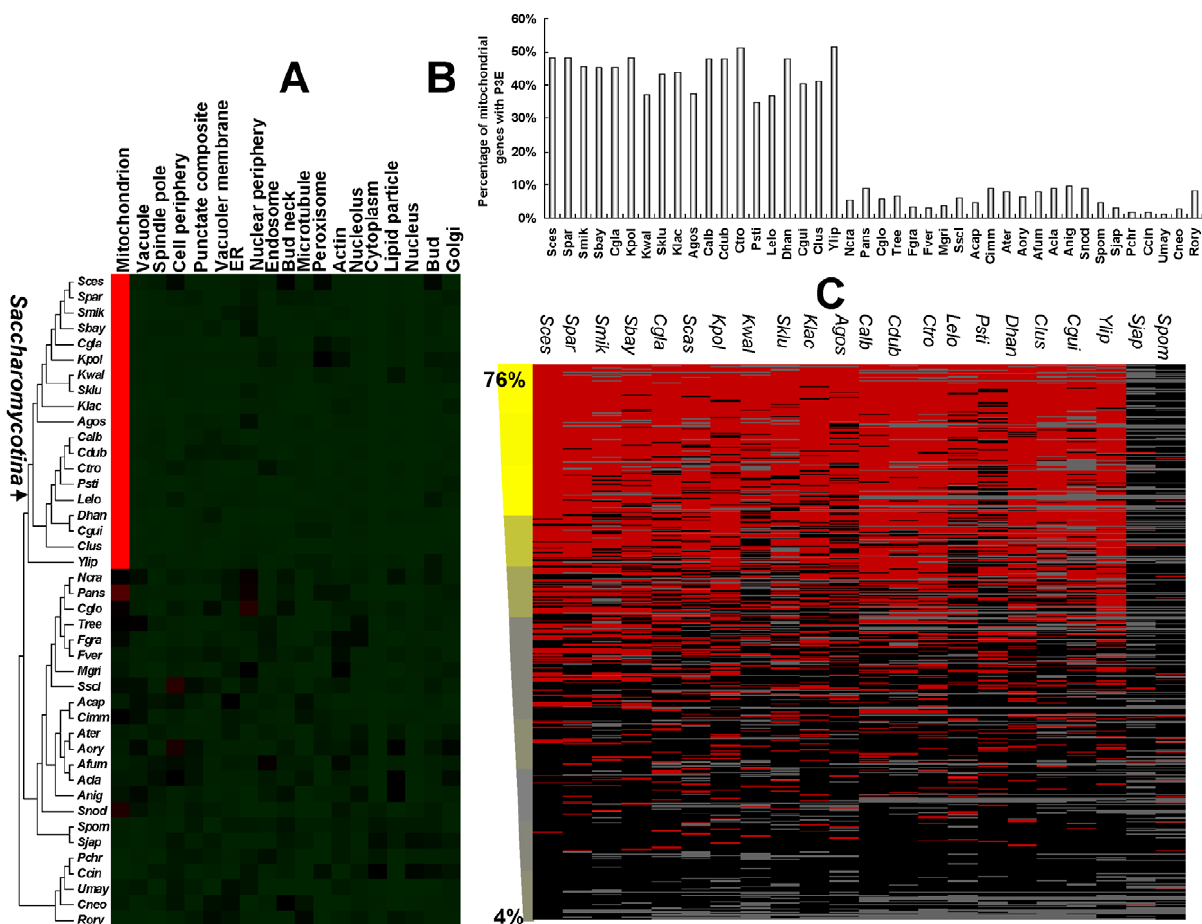
Figure 2. The evolution of the puf3p regulon and mitochondrial biogenesis. (A) Enrichment of P3E in different categories in yeast species. Red color denotes significant enrichment of P3E after multiple test correction ( P -value , 0.01). Black and green denote P -value=0.01 and P - value . 0.01 respectively. (B) The occurrence of P3E for genes functioning in mitochondria in yeast species. The y axis represents the percentage of P3E conservation in mitochondrial genes for each studied species. (C) Conservation of P3E for genes involved in mitochondrial translation. Each row represents a mitochondrial gene and each column represents a species in the clade Saccharomycotina ( S. pombe and its sister species, S. japonicus , which do not have P3E enrichment in mitochondrial genes, were also shown for comparison). The presence and absence of P3E in the downstream of a mitochondrial gene is shown in red and black, respectively. The grey denotes the absence of the corresponding orthologous gene in that species. Genes were sorted by the percentage of having P3E among all orthologs for each gene in the Saccharomycotina species (decreasing from top to bottom). The percentages of genes that are involved in mitochondrial translation, which were defined based on the Gene Ontology annotation (GO: 0006412), were calculated in a 50 gene sliding window from top to bottom, and the values were listed at the left of the figure.